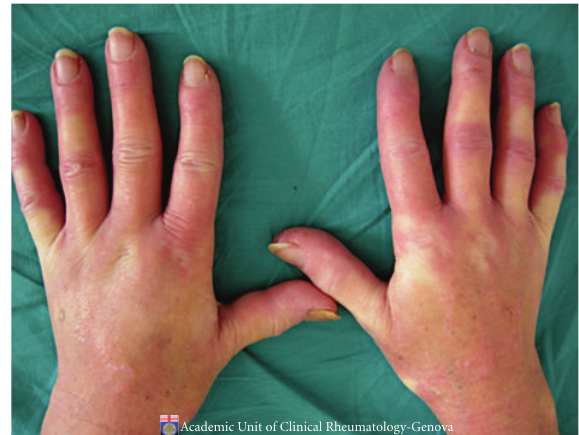
Figure 1: Hands of a patient with early systemic sclerosis su ff ering from secondary Raynaud’s